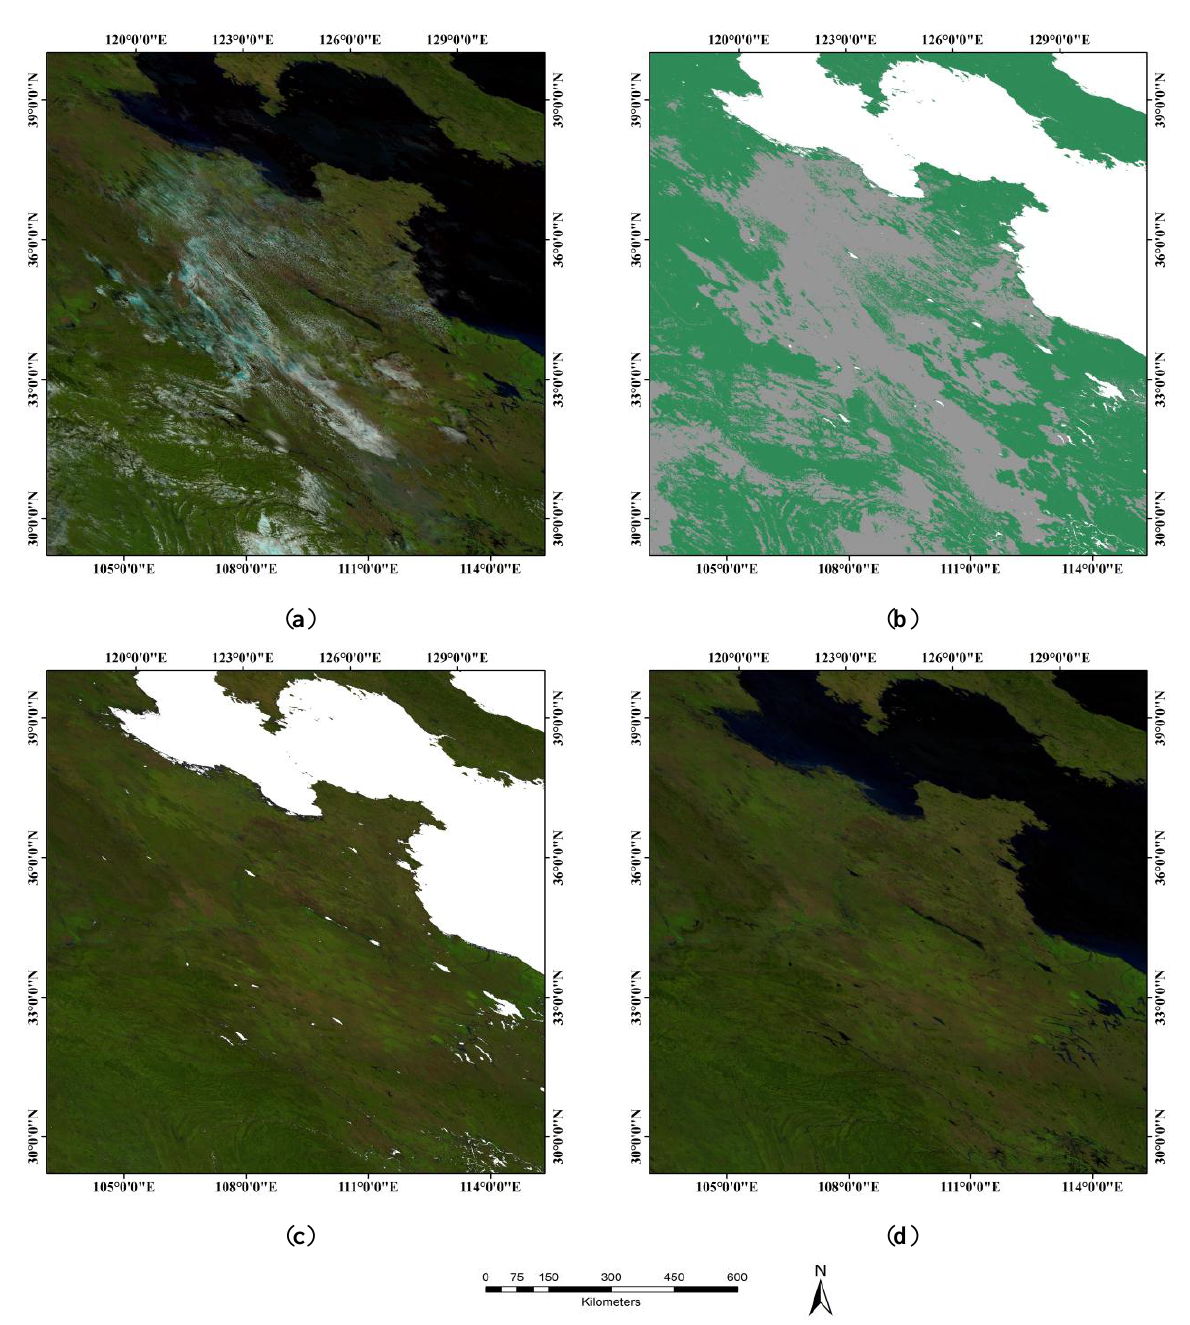
algorithm. From the RGB image in Figure 2c,d, the VIRR and TSCD methods removed the residual clouds in the surface reflectance from MOD09A1.